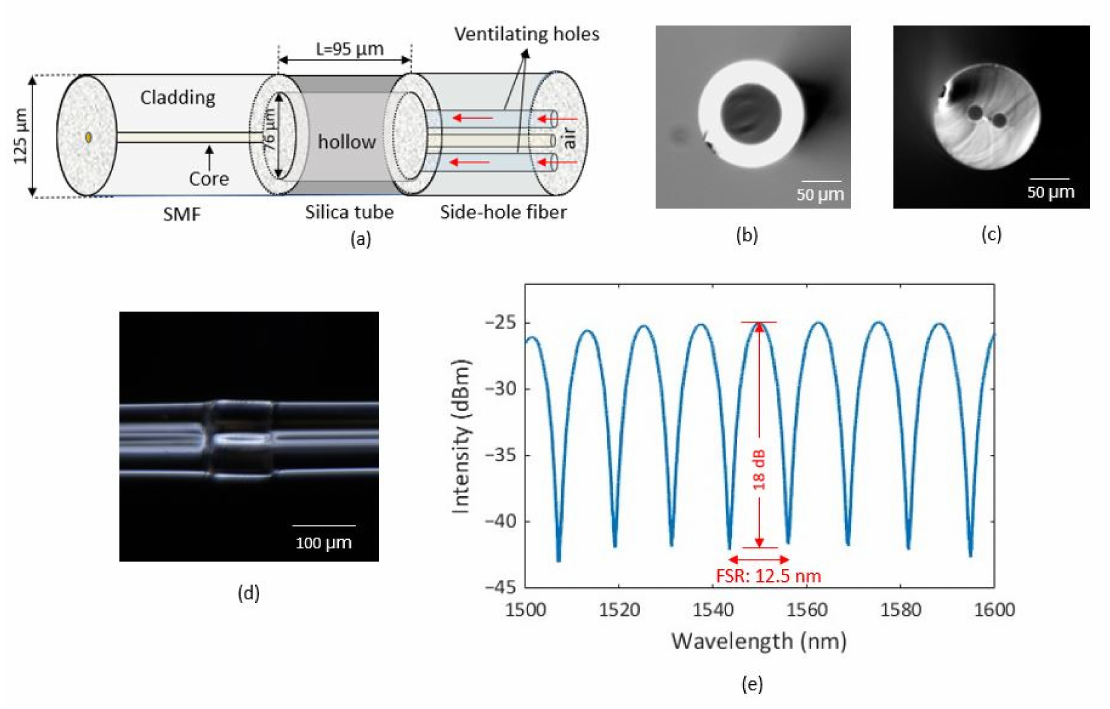
Figure 1. ( a ) Schematic of the sensor; ( b , c ) cross-section of silica tube and side-hole fiber, respectively; ( d ) microscopic longitudinal view of the fabricated sensor; ( e ) reflection spectrum of the sensor at ambient temperature and